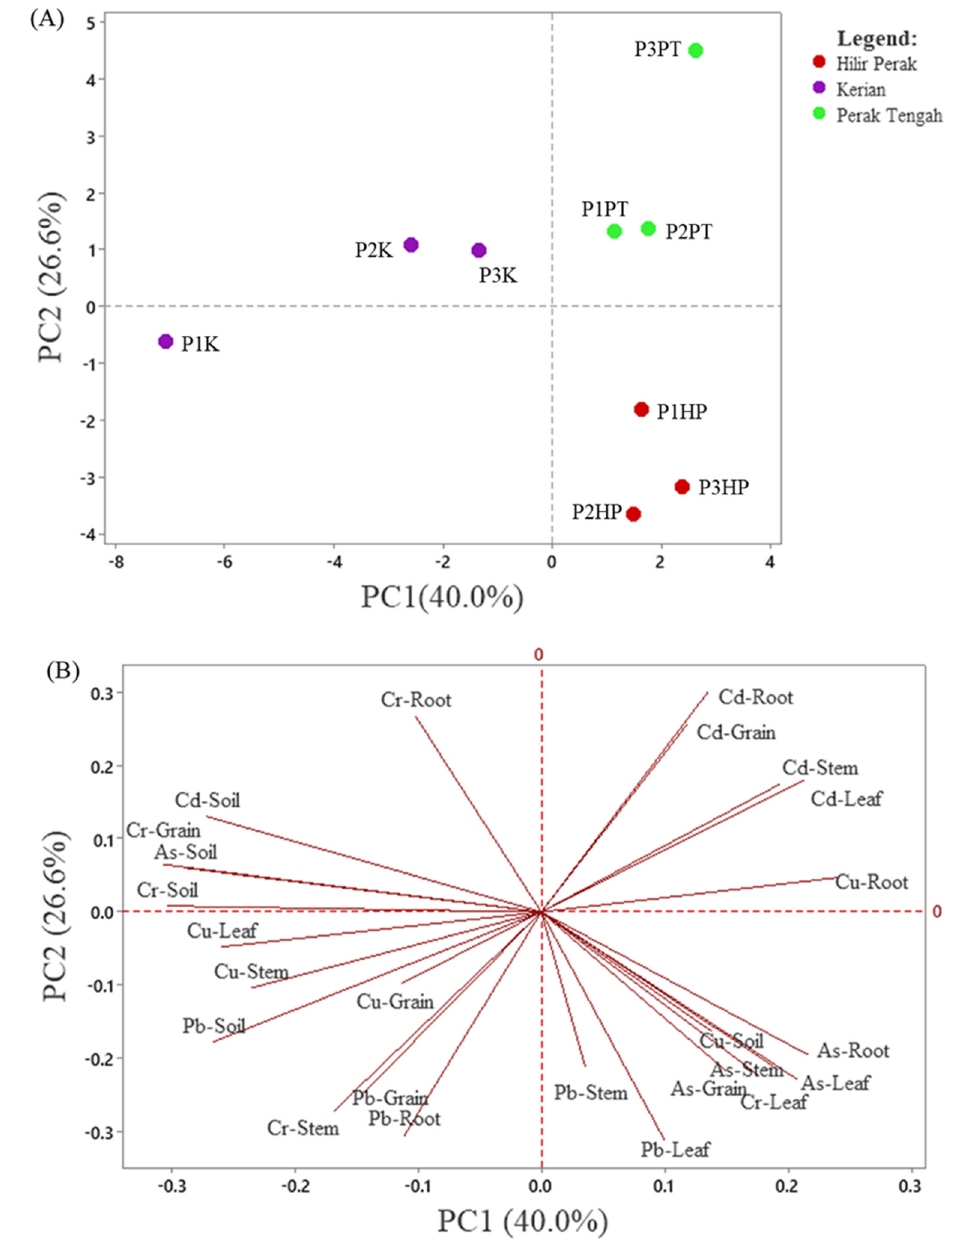
Figure 3. PCA score ( A ) and loading ( B ) plots of the different sampling areas. P1K, Plot 1 Kerian; P2K, Plot 2 Kerian; P3K, Plot 3 Kerian; P1PT; Plot 1 Perak Tengah; P2PT, Plot 2 Perak Tengah; P3PT, Plot 3 Perak Tengah; P3PT, Plot 3 Perak Tengah; P1HP, Plot 1 Hilir Perak; P2HP, Plot 2 Hilir Perak; P3HP, Plot 3 Hilir Perak.